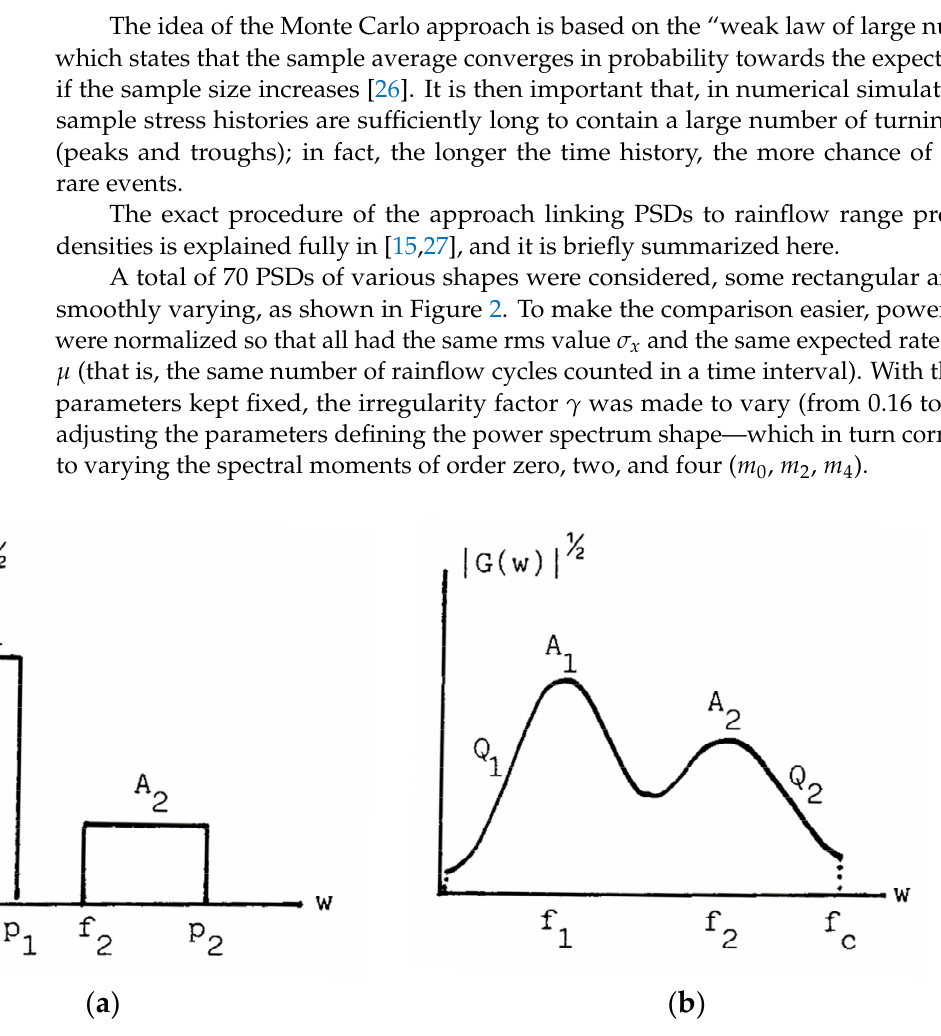
Figure 2. Types of PSD used in numerical simulations used to develop the Dirlik method: ( a ) rectangular bimodal spectrum; ( b ) smooth spectrum. Figures are from [15].